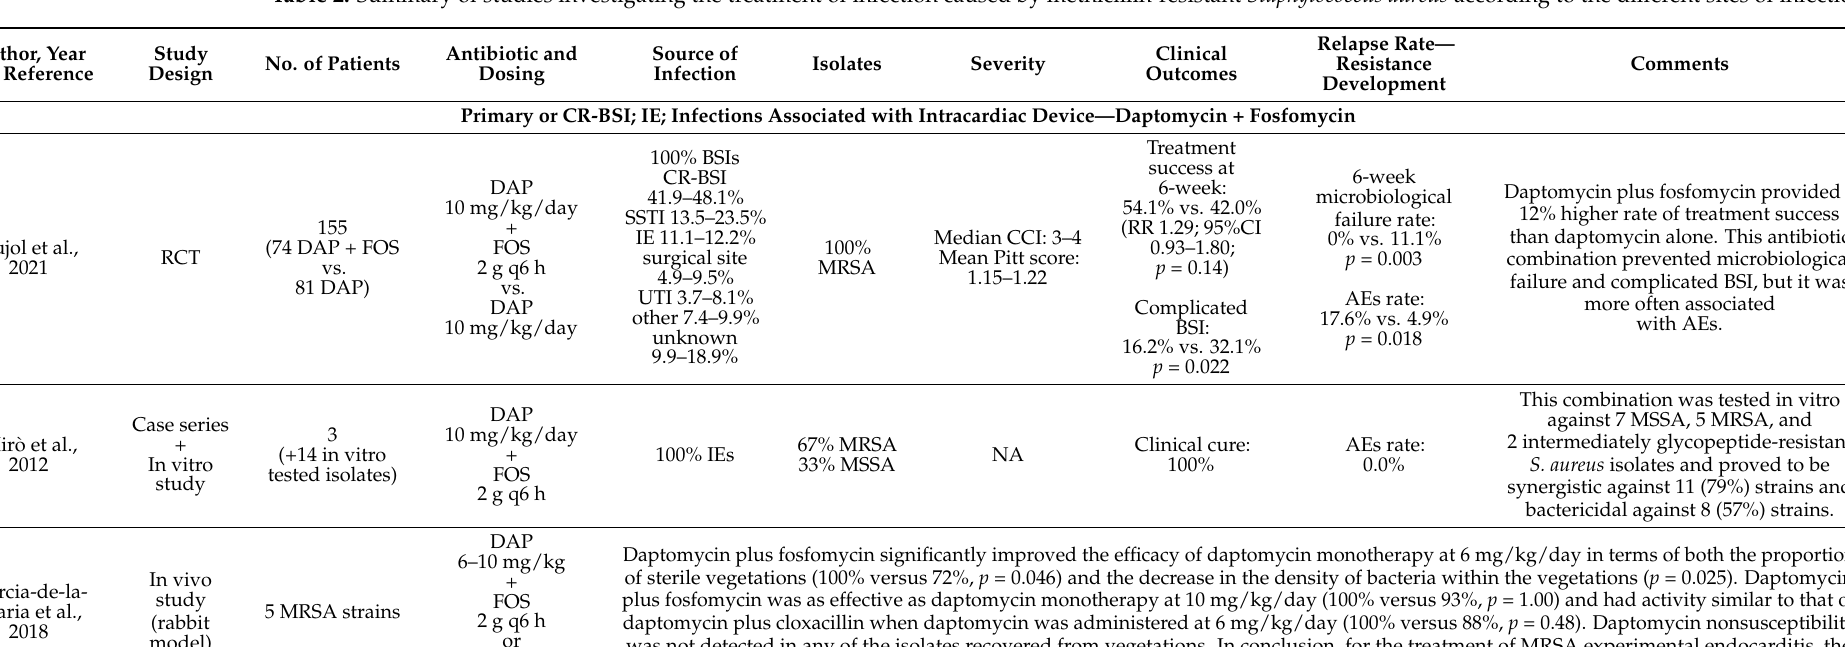
Table 2. Summary of studies investigating the treatment of infection caused by methicillin-resistant Staphylococcus aureus according to the different sites of